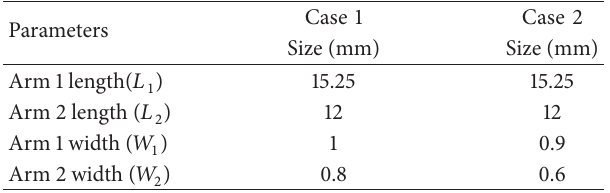
Table 1: The parameters of the three coax-fed dual-band antenna cases.